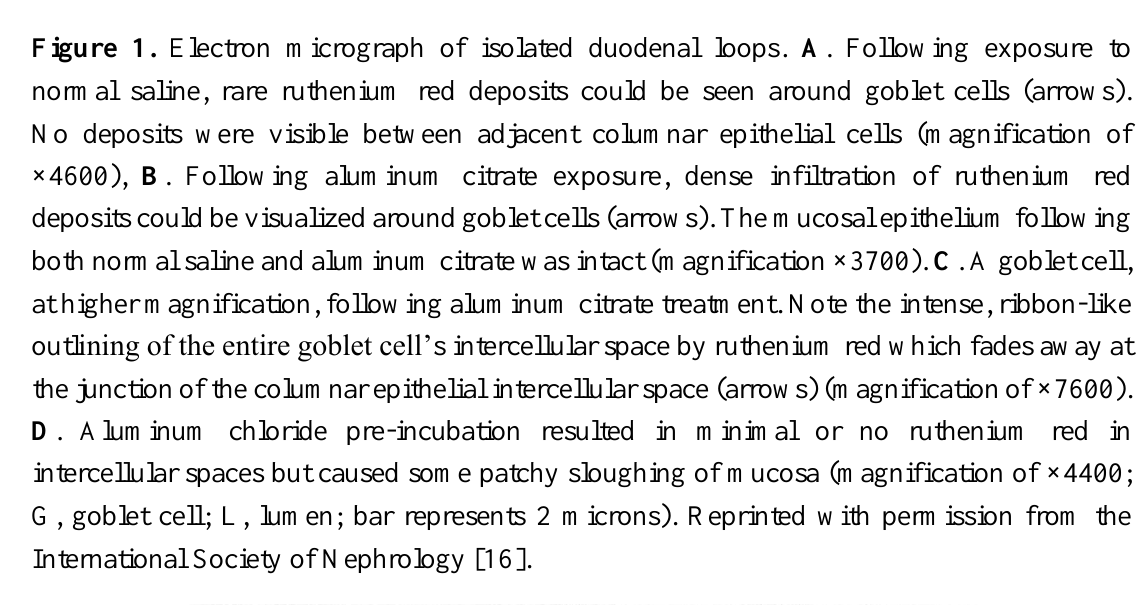
Figure 1. Electron micrograph of isolated duodenal loops. A . Following exposure to normal saline, rare ruthenium red deposits could be seen around goblet cells (arrows). No deposits were visible between adjacent columnar epithelial cells (magnification of ×4600), B . Following aluminum citrate exposure, dense infiltration of ruthenium red